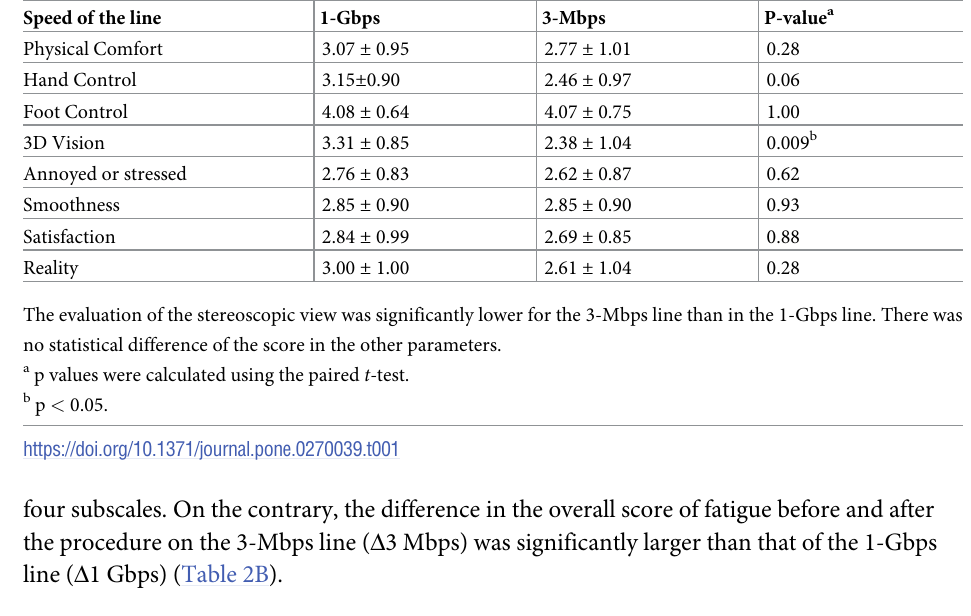
Table 1. Comparison of Robot Usability Score across line bandwidths.